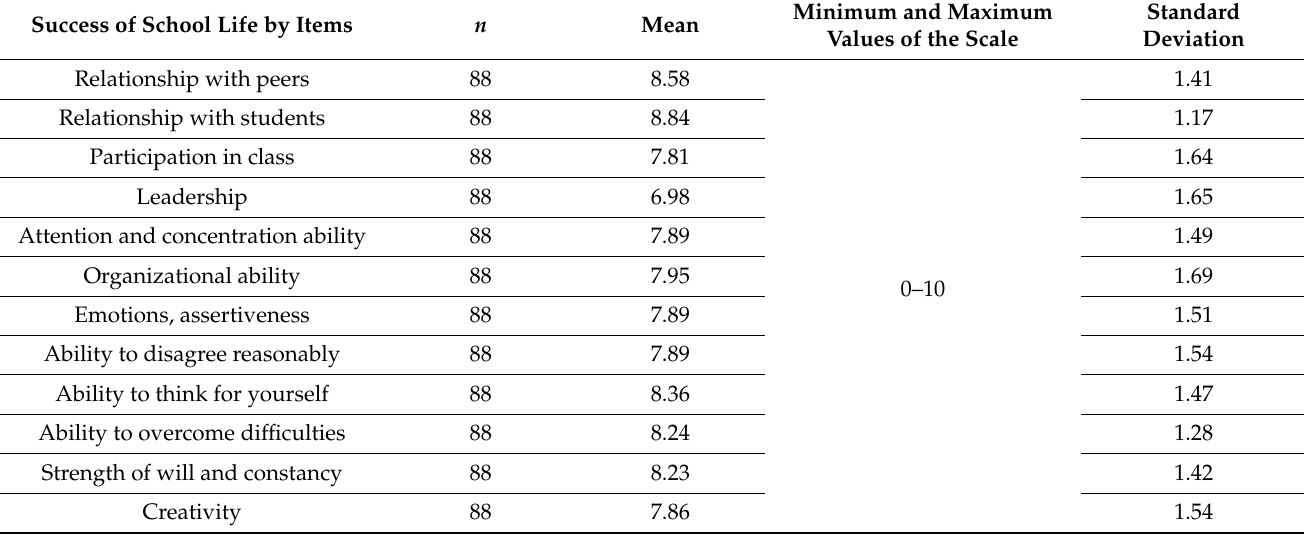
Table A6. Means and standard deviations of the Success of School Life scale. Source: own